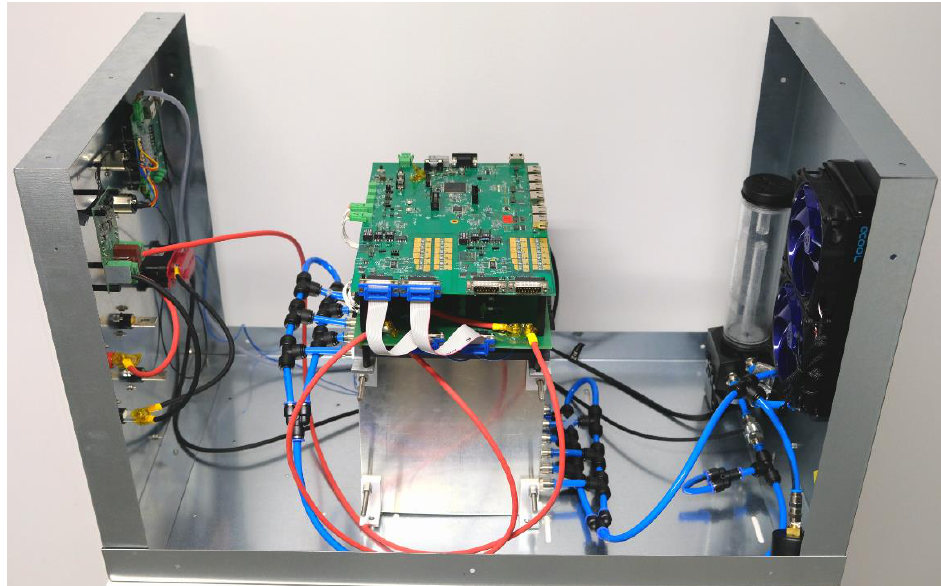
Figure 10. Photo of the battery module with the integrated cooling system. On top of the batteries in the middle part is the BMS placed. The power electronics is mounted directly below the BMS and on the left-hand side of the box. On the right-hand side pump, fans, and the cooling system radiator are placed.